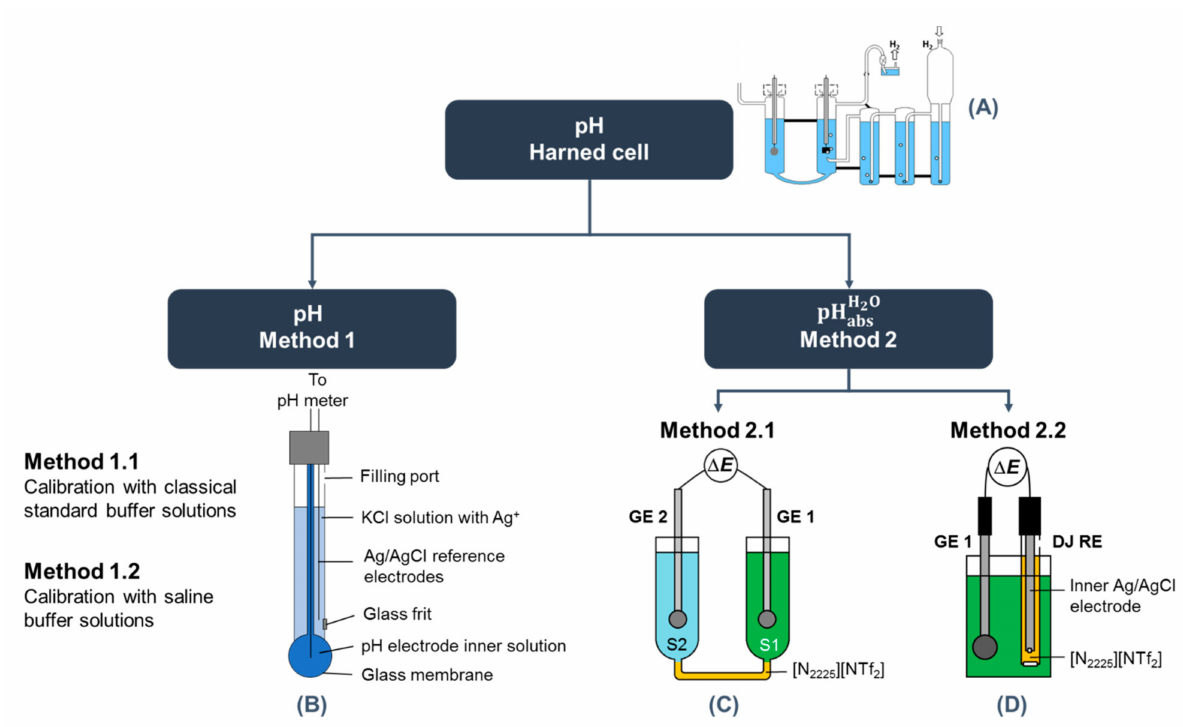
Figure 2. Schematic overview of conducted measurements with different methods: ( A ) Harned cell; ( B ) schematic overview of combination glass electrode; ( C , D ) differential potentiometric cell used for measurement of reference pH H 2 O represents the glass electrode, S the solution, and DJ RE is the double junction reference